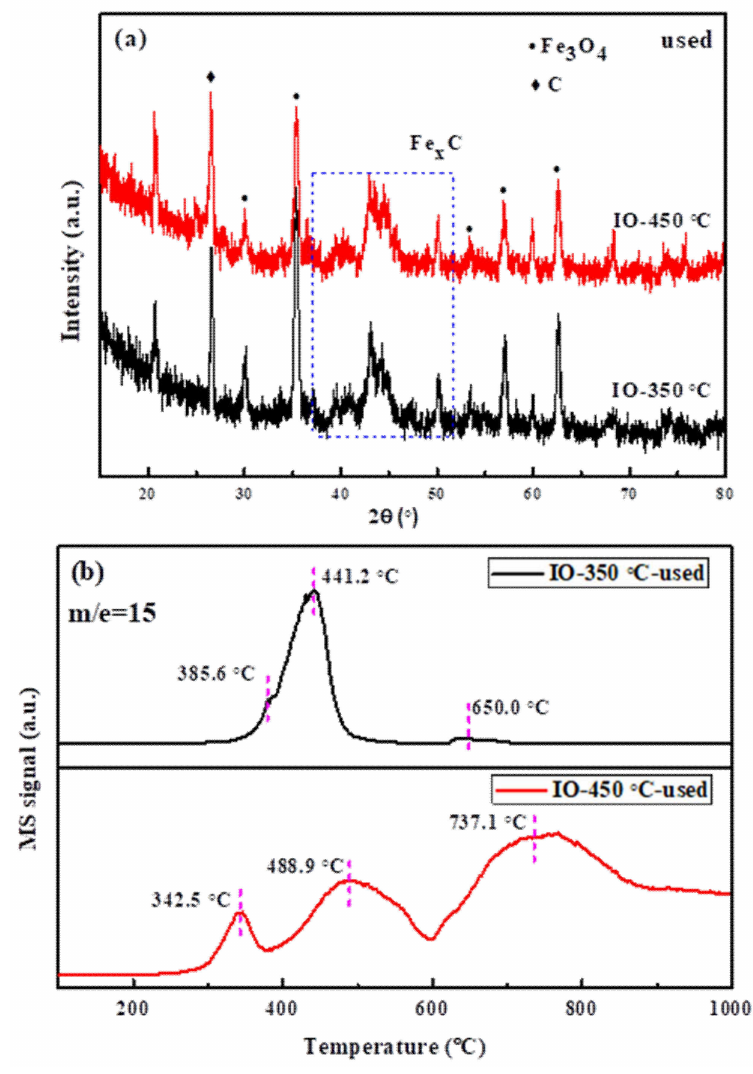
Figure 7. ( a ): The X-ray di ff raction (XRD) patterns of the used IO-350 ◦ C, IO-450 ◦ C catalysts; ( b ): The temperature-programmed hydrogenation (TPH) profiles of the used IO-350 ◦ C, IO-450 ◦ C catalysts for m / e =